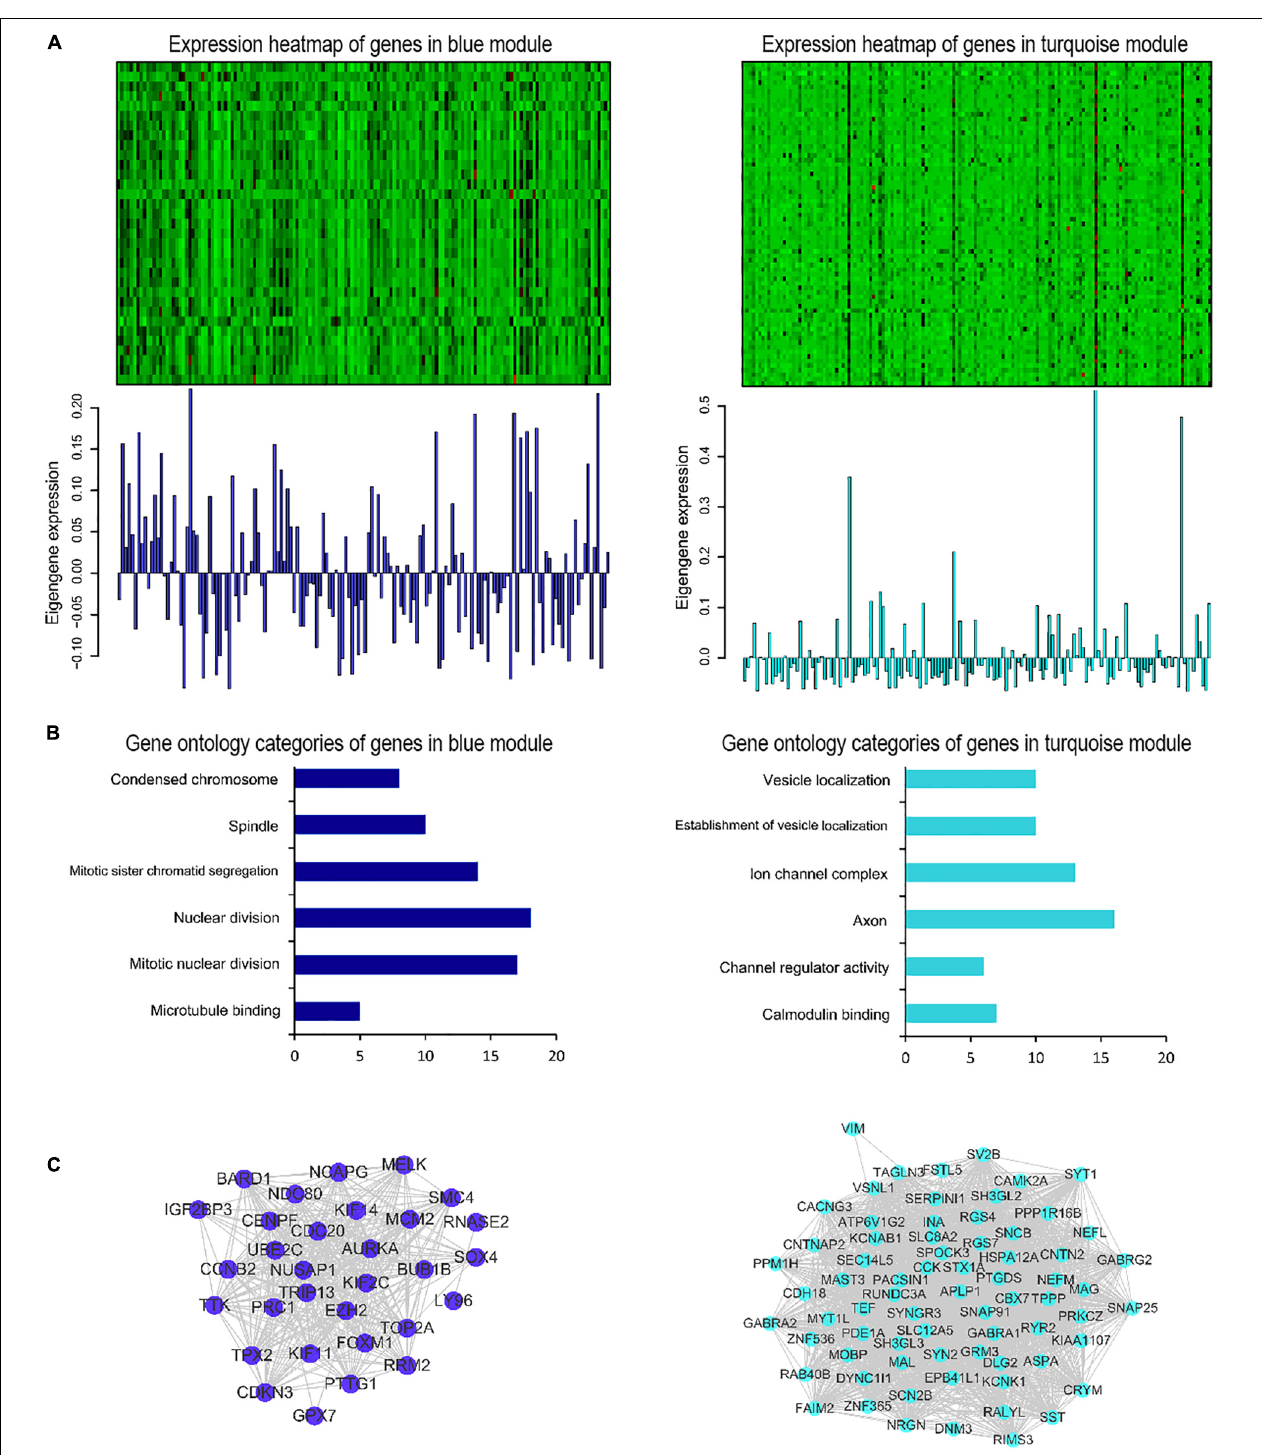
FIGURE 4 | Gene co-expression modules associated with glioblastoma. (A) Heatmap of genes belonging to the co-expression module. Corresponding module eigengene values (y-axis) across samples (x-axis). (B) Relevant gene ontology categories of enriched genes in the blue and turquoise modules. (C) Visualization of the gene co-expression network of the blue and turquoise